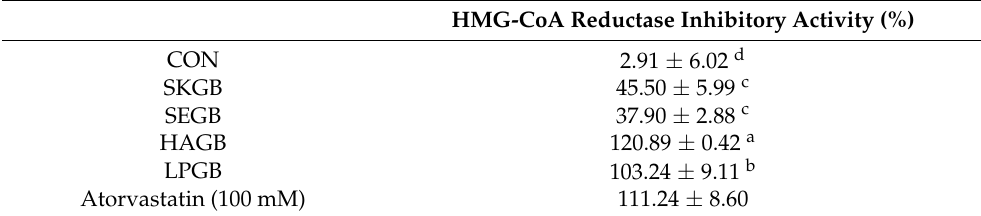
Values are mean ± standard error ( n = 2). Means with different superscripts in a column (a–d) are significantly different in terms of Fisher’s least significant difference test ( p <